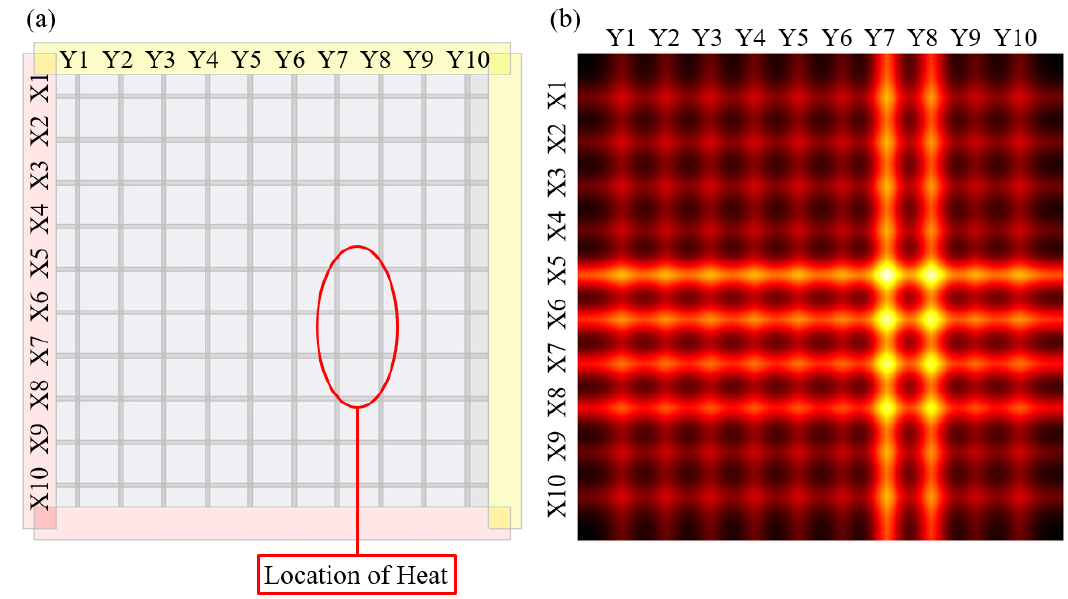
Figure 10. Heating position and visualized heat detecting technology.